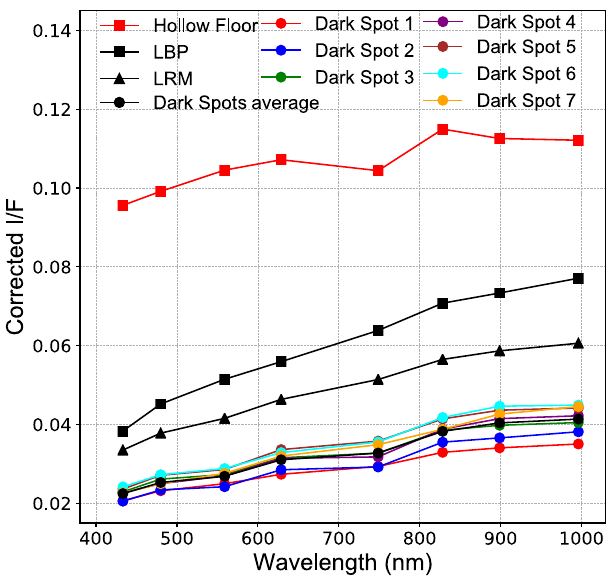
Fig. 2 Re fl ectance spectra of dark spots and their comparisons with those of hollow fl oors 15 , LRM 54 , and LBP 54 on Mercury. Black dots are the average re fl ectance spectra of the seven dark